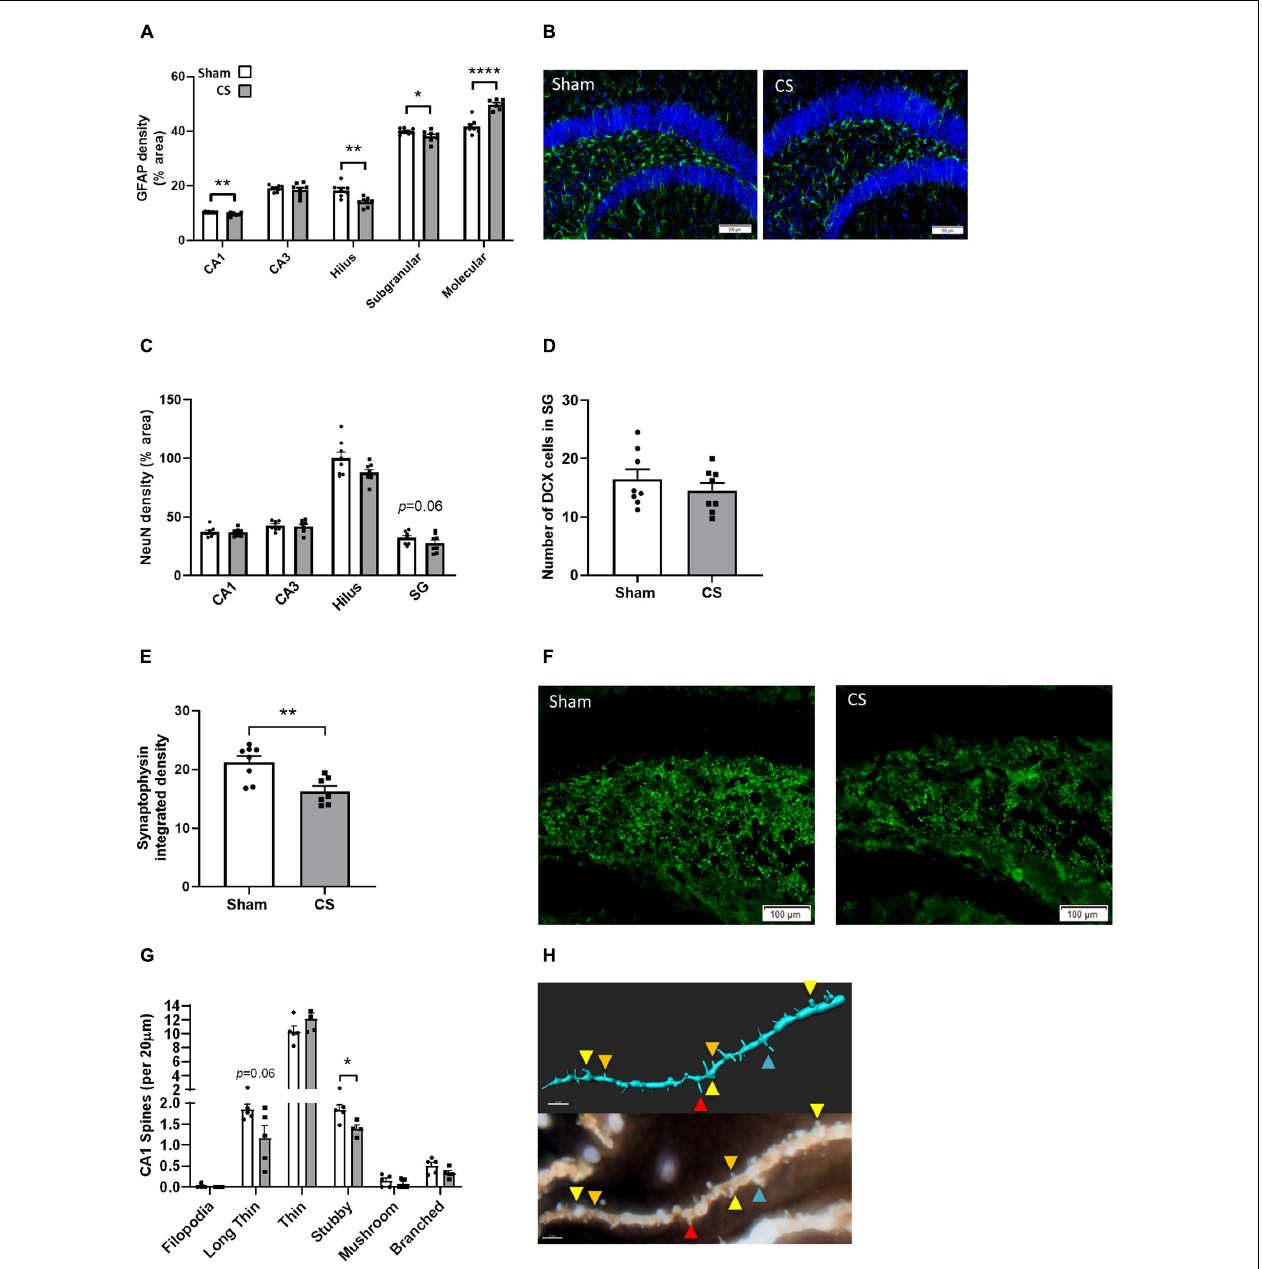
FIGURE 7 | Chronic CS exposure decreased astrocyte numbers and altered synaptogenesis in the hippocampus. (A) Mouse hippocampi were stained with glial fibrillary acidic protein (GFAP) for the assessment of astrocytes in all hippocampal regions. (C) Mature neurons (NeuN-positive cells). (D) Immature neurons DCX-positive cells. (E) Synaptophysin staining in the hilus region of the dentate gyrus. (G) Golgi staining of secondary pyramidal neurons spines in the CA1 ( n = 4–5). Representative images of (B) GFAP, (F) synaptophysin, and (H) golgi staining (red, long thin spine; orange, thin spine; yellow, stubby spine; blue, branched spine). Data was analyzed by Student’s t -test and expressed as mean + SEM with significance being represented as; * p < 0.05, ** p < 0.01, **** p < 0.001. n =